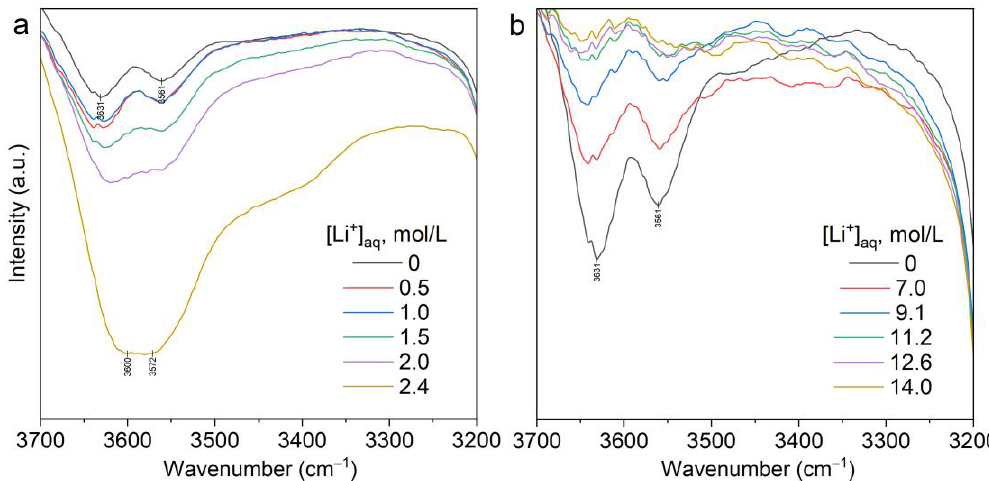
Figure 13. FTIR spectra of LiNTf 2 ( a ) and LiCl ( b ) blank extraction in [C8mim][NTf 2 ] with different [Li + ] aq. contents.